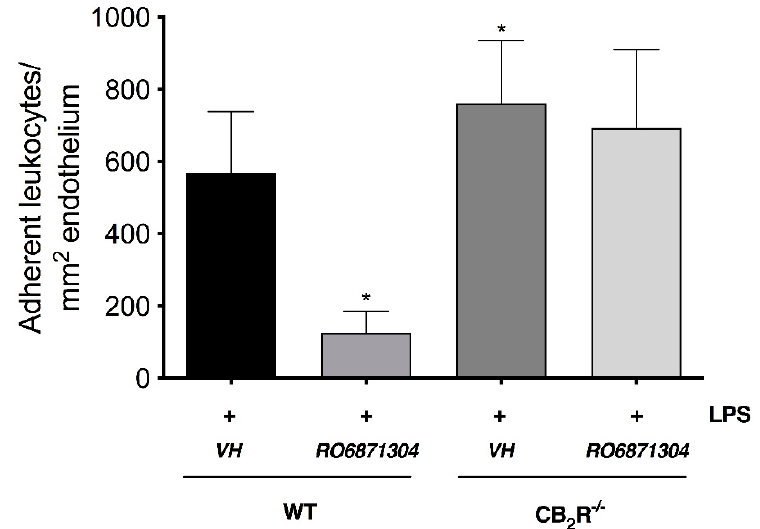
Figure 2. RO6871304 exerts its anti-inflammatory effects through CB 2 R. CB 2 R -/- mice with EIU exhibit increased iridial leukocyte-endothelial adhesion compared to wild-type (WT). Bar graph represents the mean number of adherent leukocytes in WT or CB 2 R -/- mice 6 h following intravitreal injection of LPS and topical treatment with either vehicle (Tocrisolve, n = 7) or RO6871304 (1.5% w / v ; n = 6). Data are presented as mean ± SD. One-way ANOVA with Dunnett; * p < 0.05 compared to LPS + vehicle in WT mice.